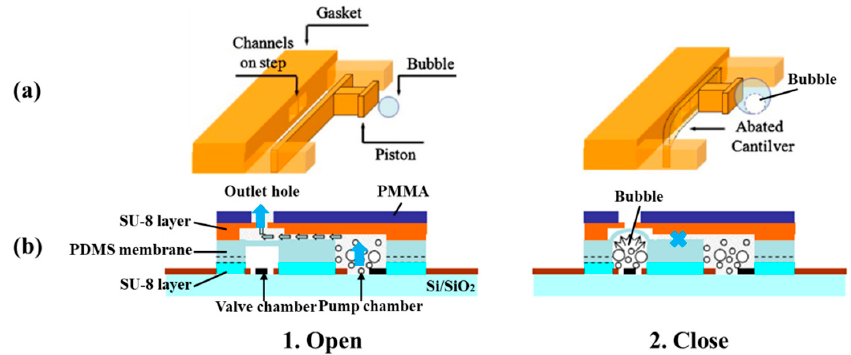
Figure 3. Two types of schematic diagrams of electrochemical actuated microvalves. ( a ) A microvalve based on electrochemically actuated SU8 cantilever [37]; ( b ) A microfluidic valve based on electrochemical (ECM) actuated membrane [39].